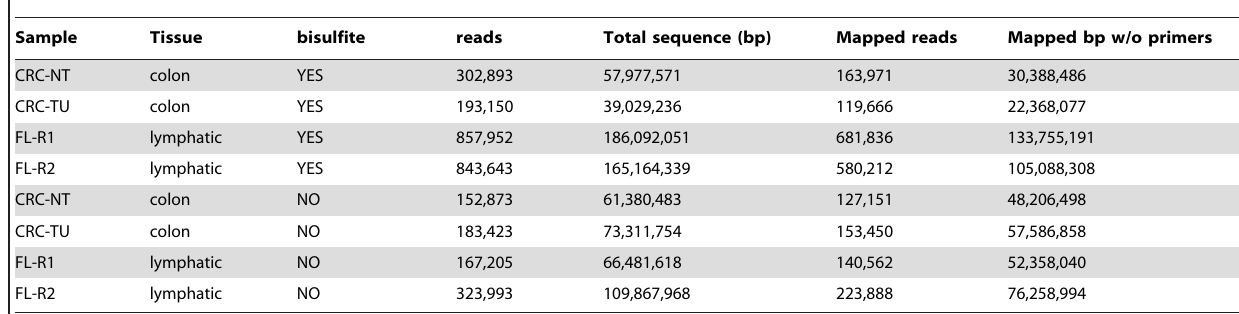
Table 1. Overview of the samples and reads from the libraries.